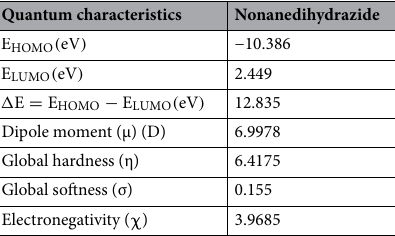
Table 9. Theoretical parameters calculated based on DFT (d,p) basis set at the B3LYP level of nonanedihydrazide.